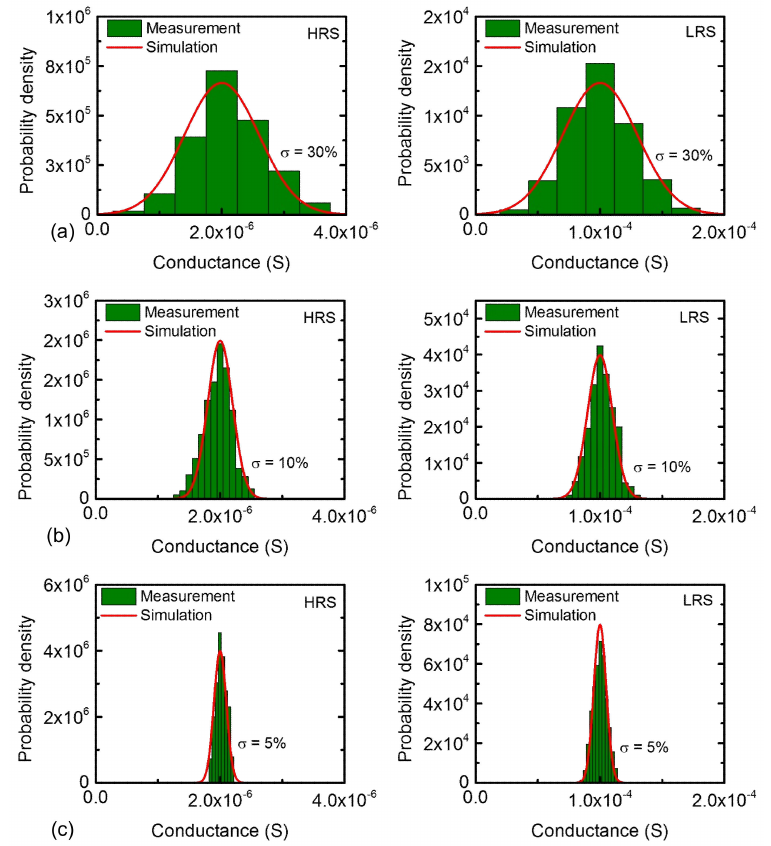
Figure 4. The memristance distributions of HRS and LRS for ( a ) the coarse programming, ( b ) the moderate programming, and ( c ) the fine programming schemes,